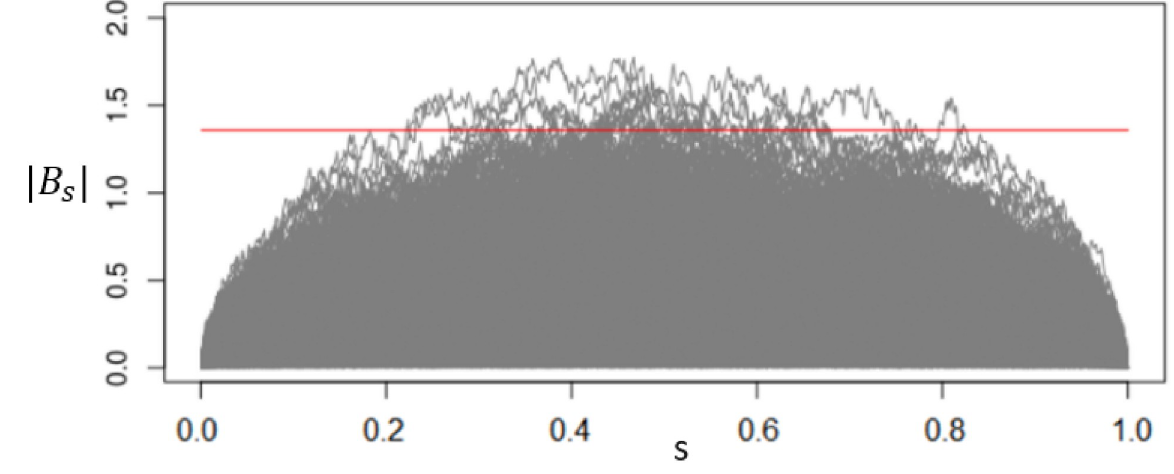
Fig 2. Control limit of the CUSUM test based on T max